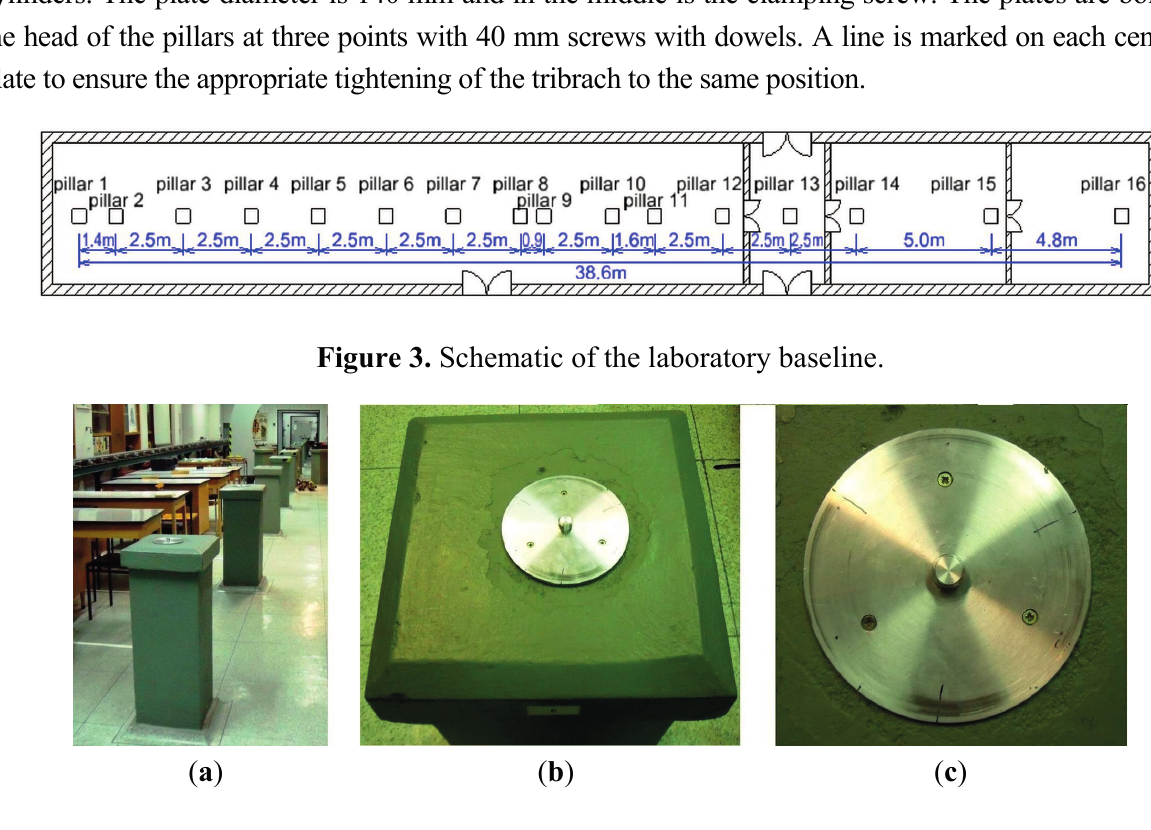
Figure 4. ( a ) The laboratory baseline; ( b ) the head of the pillar; ( c ) the centering